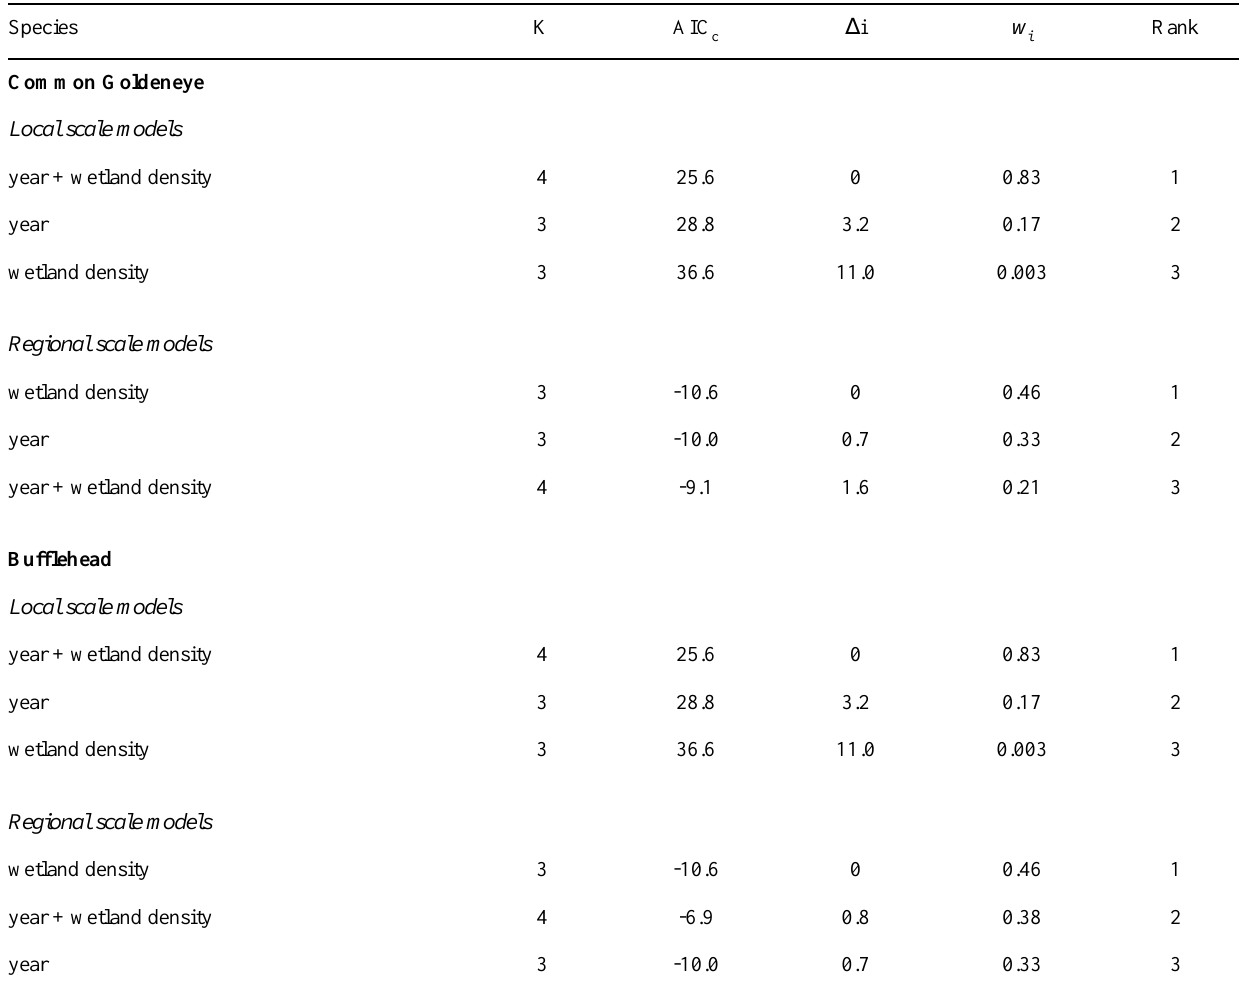
Table 2. Summary of regression models relating densities of nesting pairs of Common Goldeneye ( Bucephala clangula ) and Bufflehead ( Bucephala albeola ) to year and wetland density. D i=AICc,i – AICc, wi= Akaike